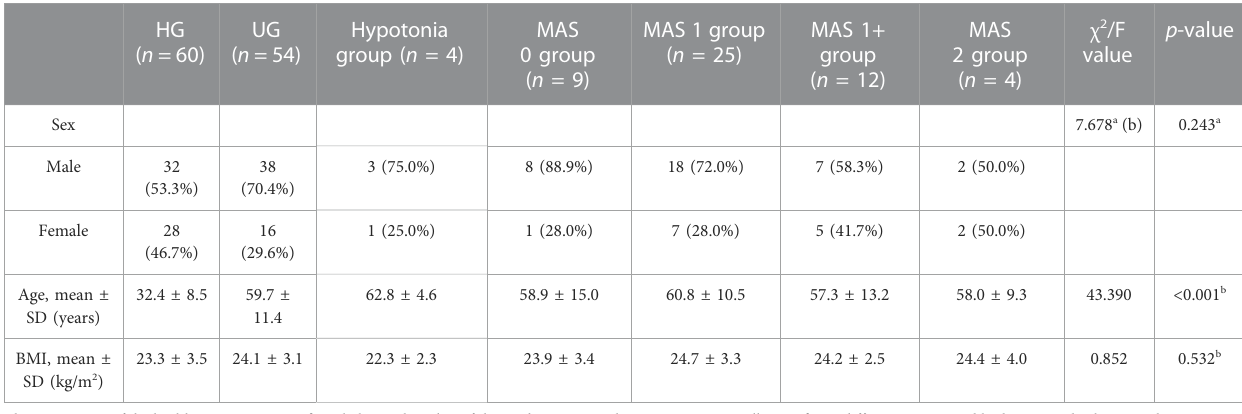
TABLE 1 Basic information of participants in each